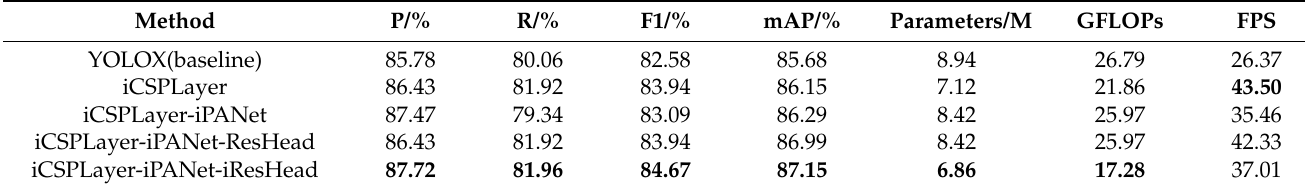
Table 3. Results of ablation experiments. The bolded parameters are the most